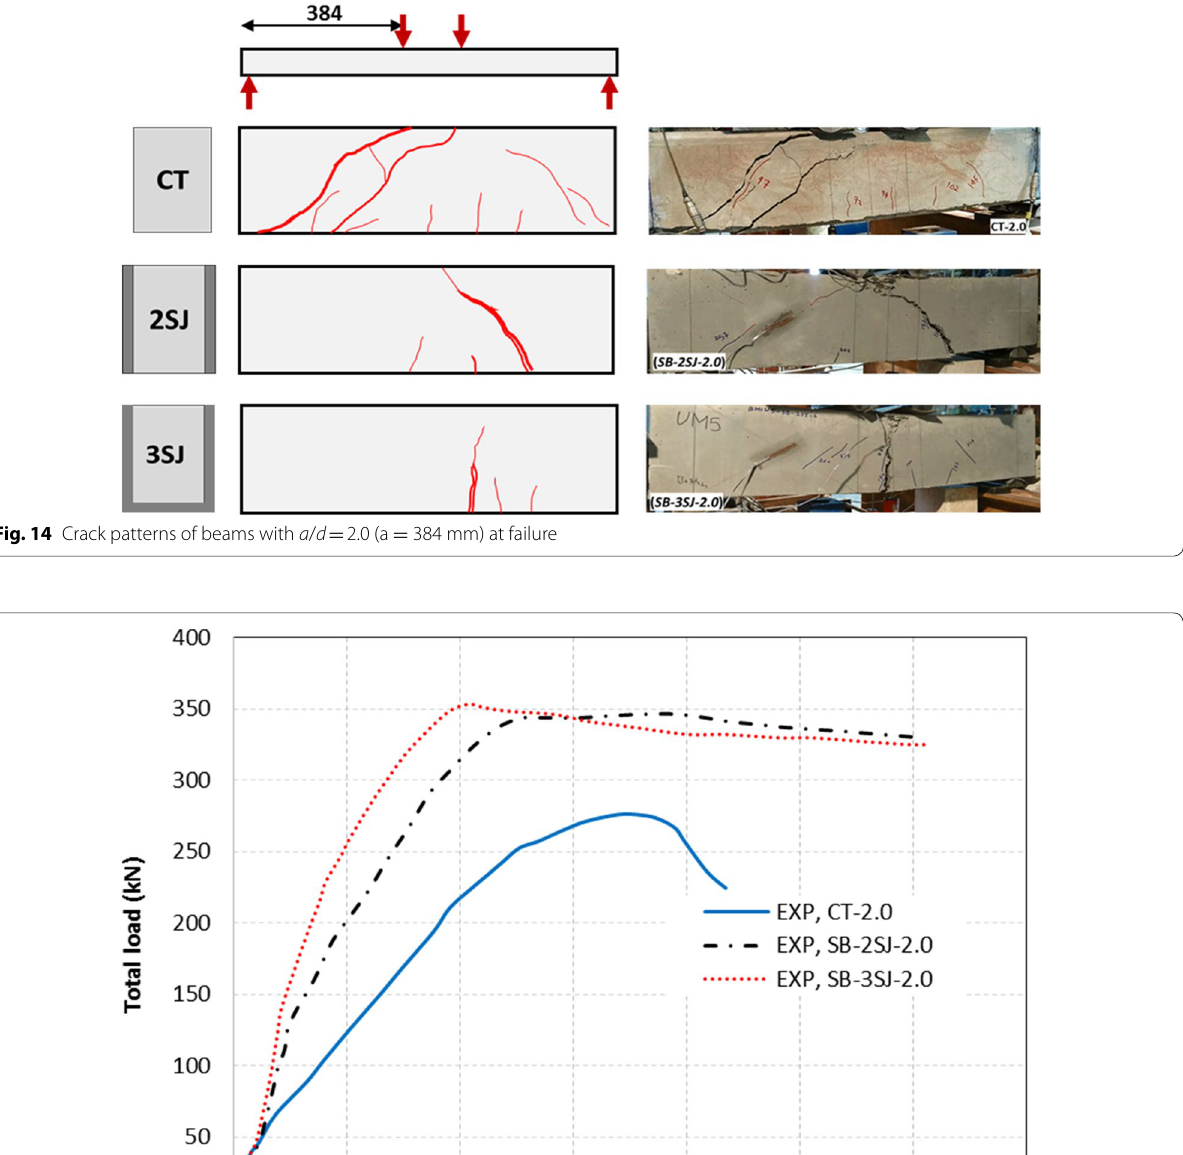
Fig. 15 Load–deflection curves of all beams with a / d